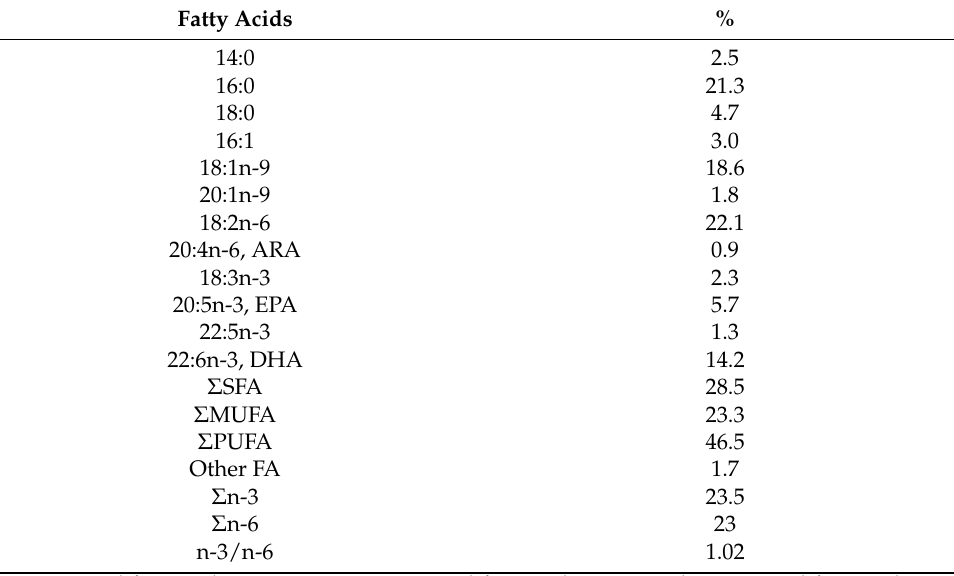
Table 1. Fatty acid profile (% of total fatty acids) of the commercial